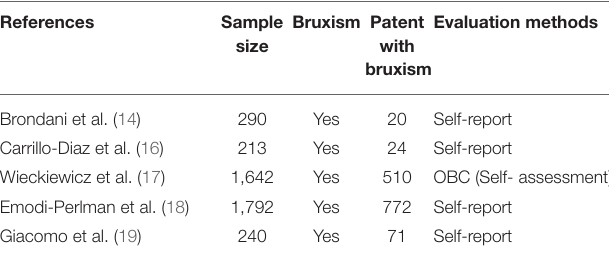
TABLE 1 | Evaluation of bruxism frequency in